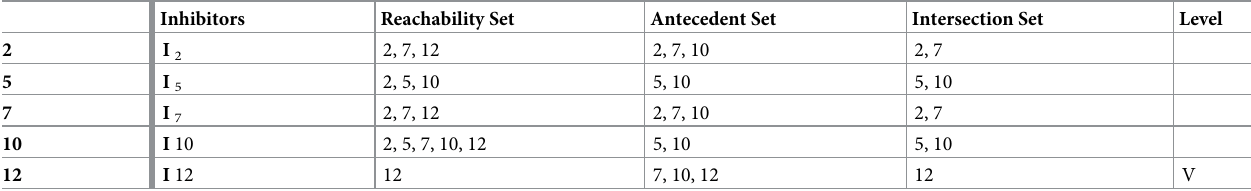
Table 11. Level partitioning